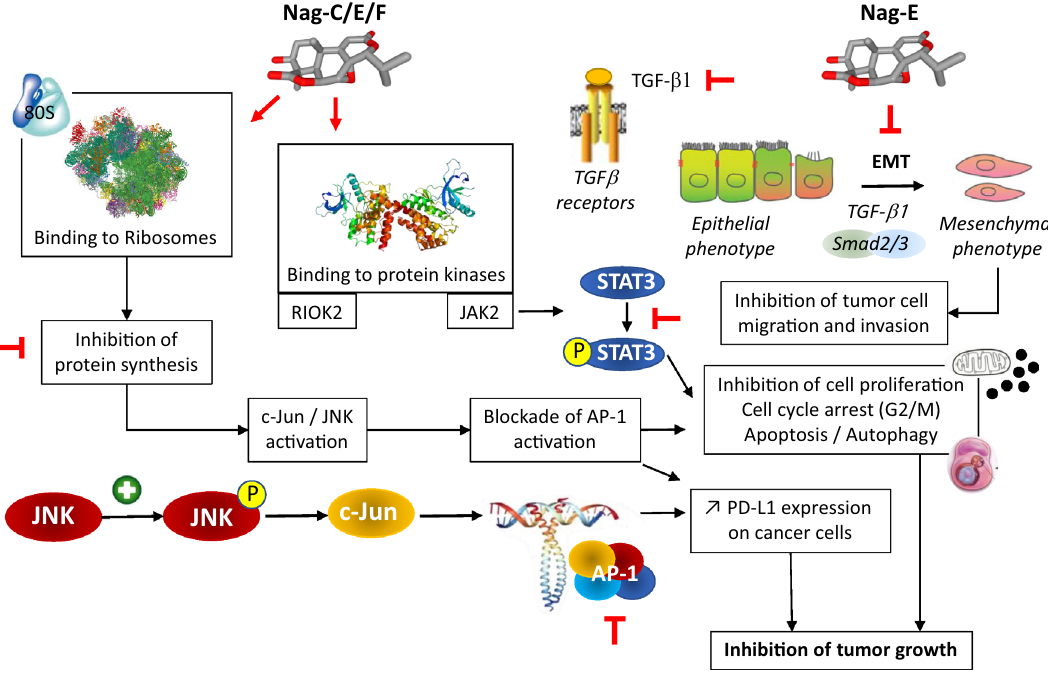
Fig. 5 Schematic view of the mechanism of action of antitumor nagi- lactones (Nag-C–E). Binding of the drug to ribosome leads to pro- tein synthesis inhibition. Binding to the protein kinases RIOK2 and JAK2 has been also reported, leading to inhibition of phospo-STAT3,